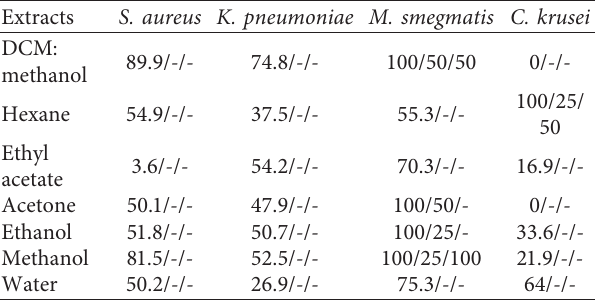
Table 2: Antimicrobial activities of the extracts on the test or- ganisms expressed as % inhibition at 100 ( µ g/mL)/MIC ( µ g/mL)/ MBC ( µ g/mL).